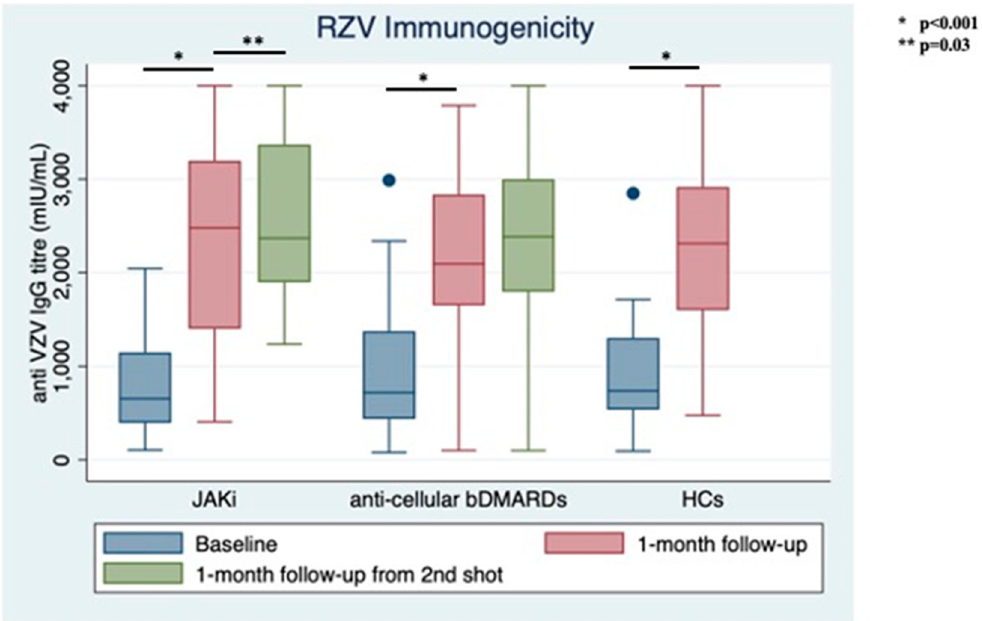
Figure 2. Immunogenicity of recombinant Adjuvanted Recombinant Zoster Vaccine (RZV) at different follow-up times stratified between treatment groups and compared with healthy controls (HCs).